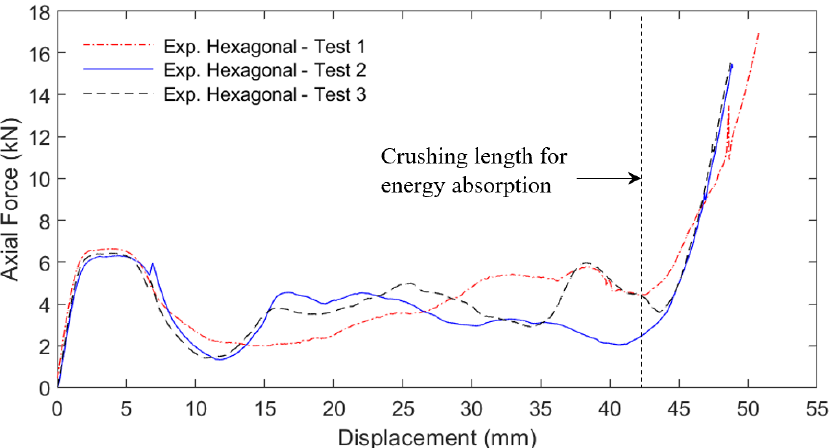
Figure 15. Load vs. displacement curves for novel cell under lateral load: comparison between experimental and FEA.